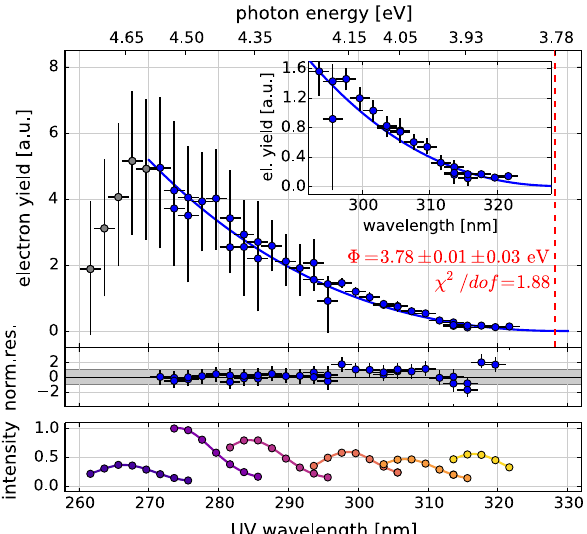
Fig. 10 Measured work function of the photocathode. The work func- tion is determined from the measured electron yield w.r.t. to the UV wavelength, a method proposed by Fowler [25]. The measurement was performed using six UV LEDs with a monochromator to select wave- lengths in the range 261–321nm. The given residuals are in absolute units. The fit results in a work function of (cid:7) = 3 . 78 ( 1 ) eV, or a corre- sponding wavelength of λ opt = 326 ( 1 ) nm as indicated by the vertical line . The data points below 270nm were excluded from the fit. The scale at the top shows the corresponding photon energy h ν for the LED peak wavelengths. The bottom plot shows the LED emission profiles with their relative